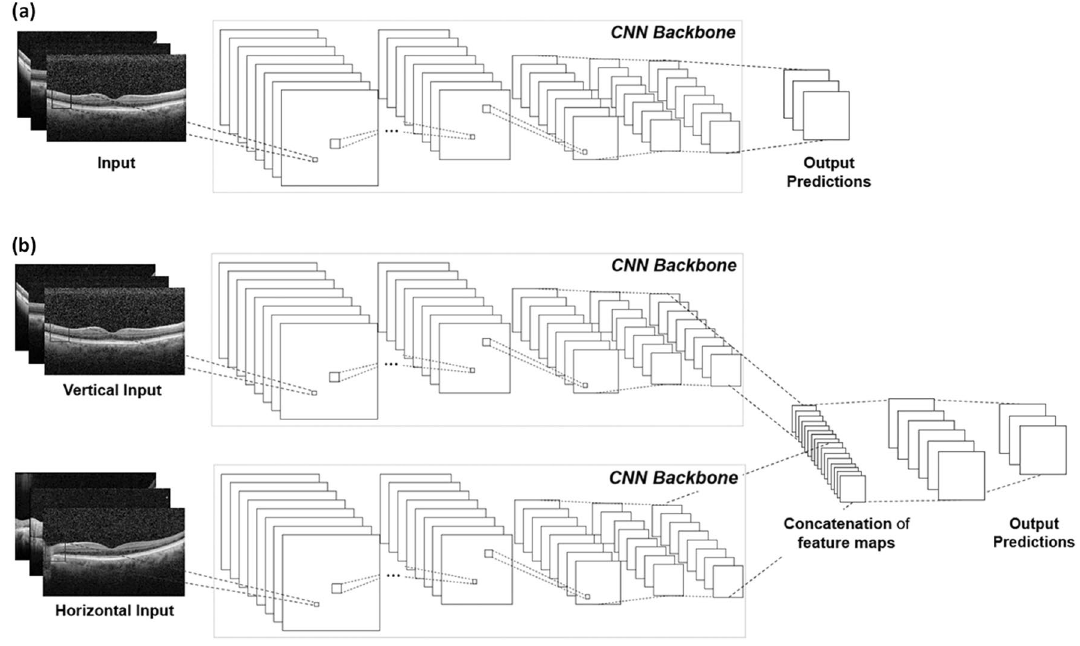
Figure 1. Overview of the framework. ( a ) Single-column model. ( b ) Multiple-column model, which considers vertical and horizontal OCT images simultaneously at each CNN feature